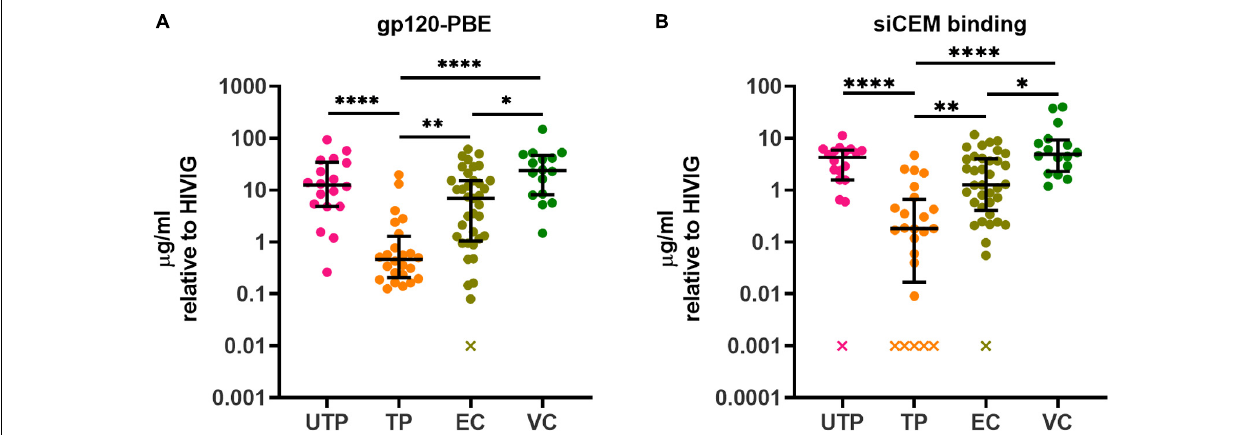
FIGURE 1 | Quantification of HIV gp120- and Envelope (Env)-specific antibodies (Abs) in plasma from HIV + subjects. The concentration of gp120/Env-specific Abs in plasma from four groups of HIV + subjects relative to HIVIG was assessed using panel (A) an ELISA assay in which plates were coated with recombinant gp120 (gp120) and (B) by measuring binding to native, closed conformation Env on sorted HIV-infected CEM.NKr.CCR5 (siCEM) cells by flow cytometry. “x” denotes sample(s) for which Abs concentrations were below the limit of detection. Each point represents results generated by the plasma of a single individual. Lines and error bars though each data set represent medians and inter-quartile ranges (IQRs). Data from 18 UTPs, 24 TPs, 37 ECs and 16 VC are used to prepare panels A and B. Kruskal-Wallis tests with Dunn’s multiple comparisons post test were used to assess the significance of between-group differences. ∗ p < 0.05, ∗∗ p < 0.01, ∗∗∗∗ p < 0.0001. HIVIG, a pool of plasma from HIV infected subjects; gp120-PBE, gp120 plate-based ELISA; UTP, untreated progressors; TP, HIV infected subjects in chronic phase infection on antiretroviral therapy; EC, Elite Controllers; VC, Viral